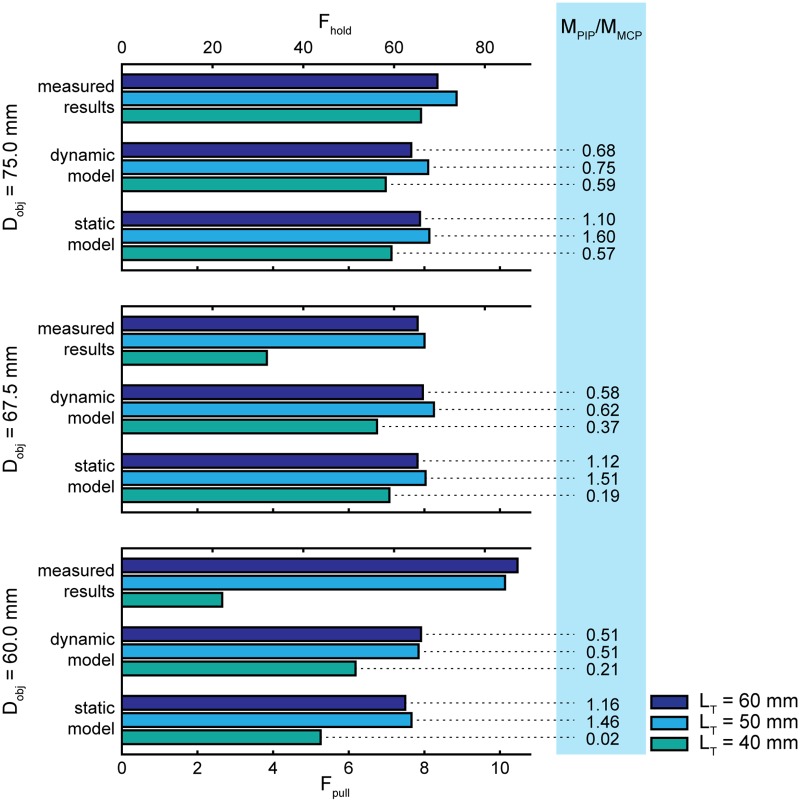
Measured and modeled results for forces related to the ability to hold objects.The sum all of normal forces (Fhold) is shown on the top horizontal axis. The force necessary to pull an object out of the grap (Fpull) is shown on the bottom axis. Additionally, the torque ratios (MPIP/MMCP) that accompany model outputs are displayed on the right.